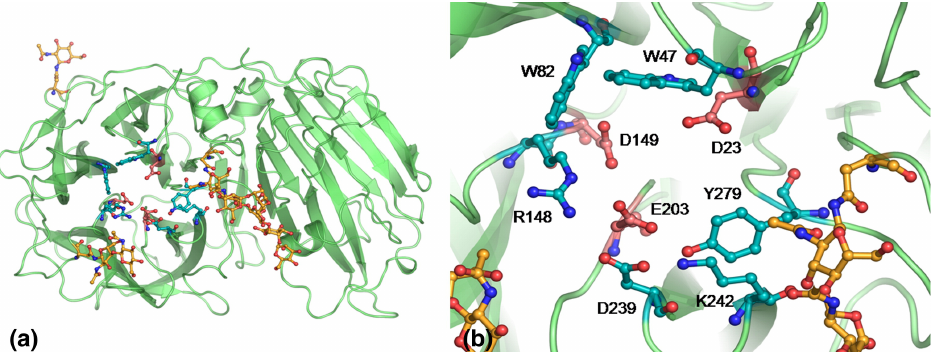
Figure 4. ( a ) AtcwINV1 invertase enzyme helix and sheet representation. ( b ) Close-up view of the ac- tive site for AtcwINV1. The conserved residues of D23, D149 and E203 are shown in red. The figure is taken from reference [98]. Reprinted from the Journal of Molecular Biology , 377, Willem Lammens et al., Crystal Structures of Arabidopsis thaliana Cell-Wall Invertase Mutants in Complex with Sucrose, 378–385, Copyright (2008), with permission from Elsevier.